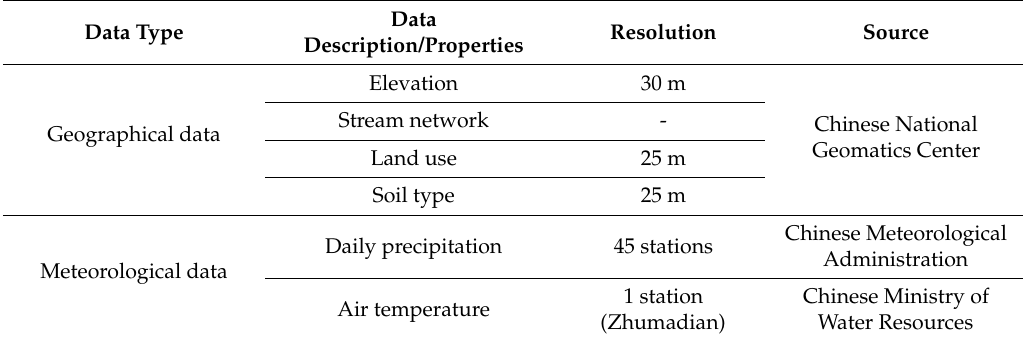
Table 3. Spatial and time series input data for the HYPE model in the Hong-Ru river